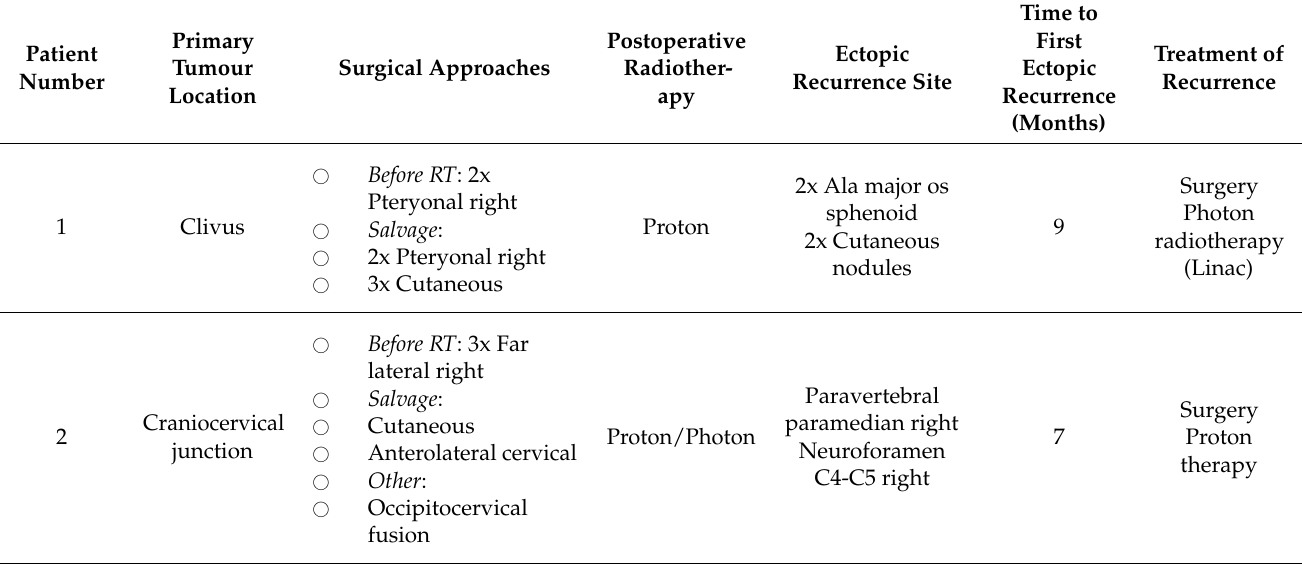
Table 1. Surgical approaches and location of ectopic recurrences. The cutaneous approach was used in subcutaneous recurrence, meaning that the skin was incised superficially to the tumor tissue. Linac = linear accelerator. GK = gamma knife. RT =